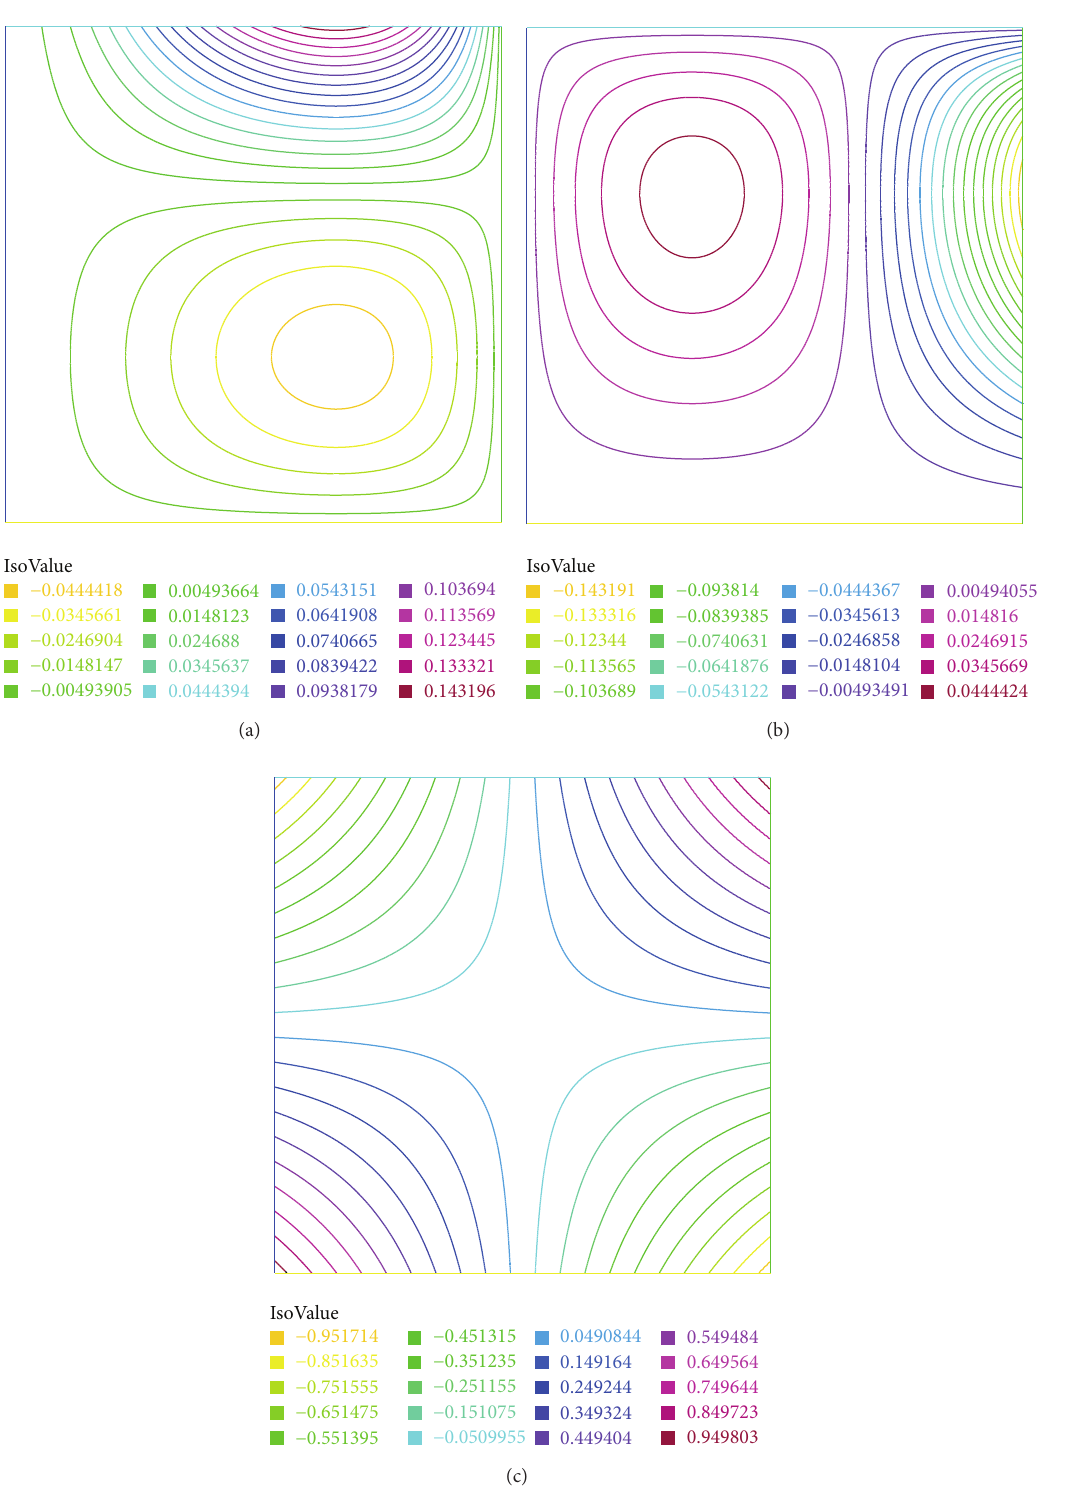
Figure 3: Contour plots of numerical solution by one-level method. From (a) to (c): two components of velocity and